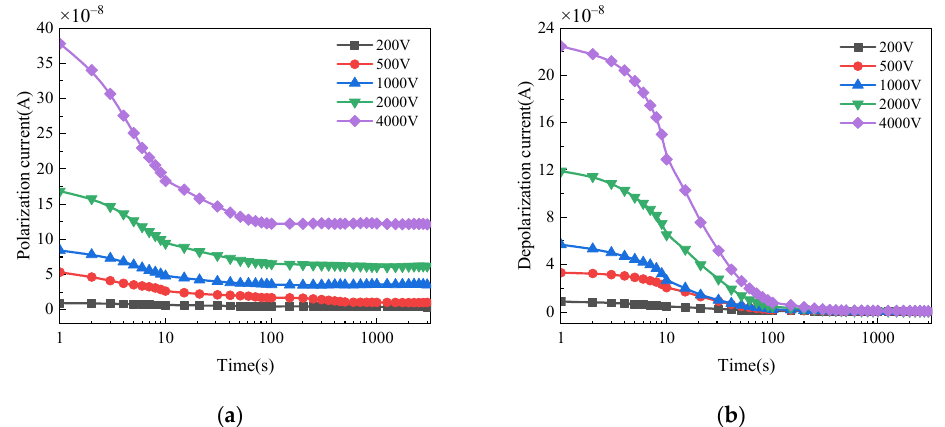
Figure 8. Polarization/depolarization current of bushing with damped oil: ( a ) Polarization current; ( b ) Depolarization current.